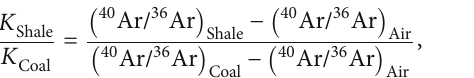
Figure 13: Adsorption capacity comparison between shales and coals: (a) M-1, coal, R coal, R o = 1 : 51 % and Y-1, R o = 1 : 57 %, shale (modi fi ed from Xia et al. [62]). The results show that the adsorption capacity of shales is greater than that of coals at a given maturity and